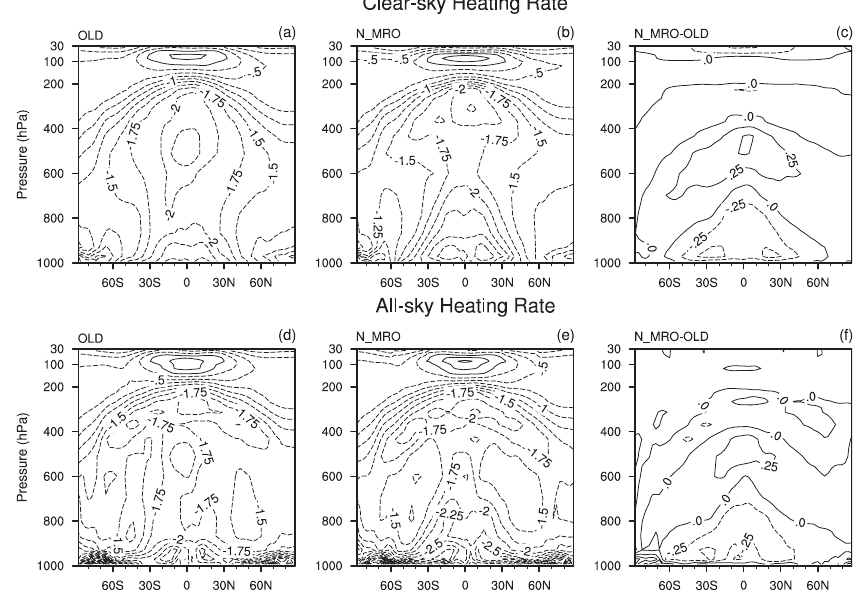
Fig. 4. Zonal annual mean clear-sky and all-sky LW heating rates for OLD (a, d) , N_MRO (b, e) and the differences between N_MRO and OLD (c, f) (units: Kday − 1 ). Table 2. The modeled and observed (SW CRF/LW CRF) ratios in